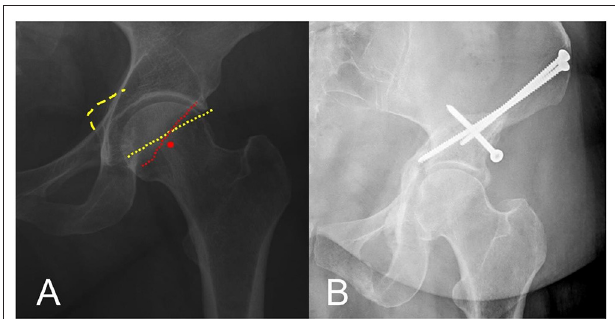
FIGURE 1 | (A) Anterior-posterior (AP) radiograph of the left hip: signs of acetabular retroversion are present; posterior wall sign (PWS), red circle; crossover sign (COS), dotted red and yellow line; ischial spine sign, dashed yellow line. (B) AP radiograph of the left hip: satisfying bony correction and correct screw placement after anteverting periacetabular osteotomy (PAO) of the left hip.